Question: Sum up the contents of this chart in one sentence.
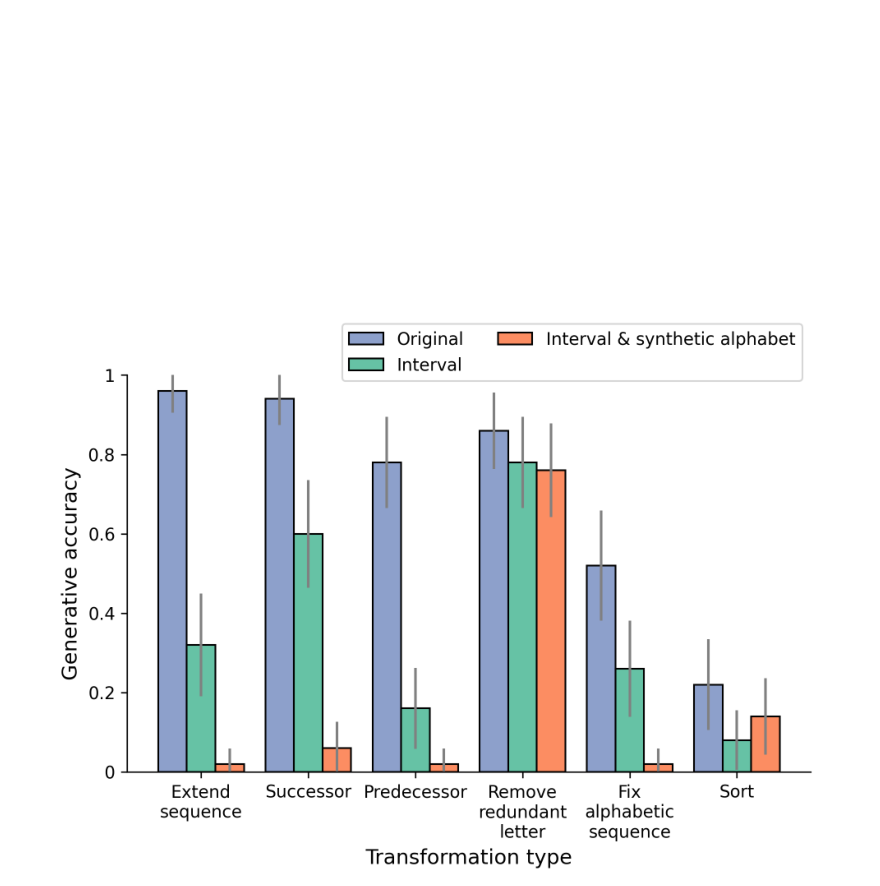
Answer: GPT-3 performance for zero-generalization letter string problems for the original experiment (blue) and with the larger interval size (green), and larger interval size with synthetic alphabet (orange). Except for ’remove redundant letter,’ GPT- 3’s accuracy declines significantly for the modified problems. The results reflect an average performance for N=50 instances.